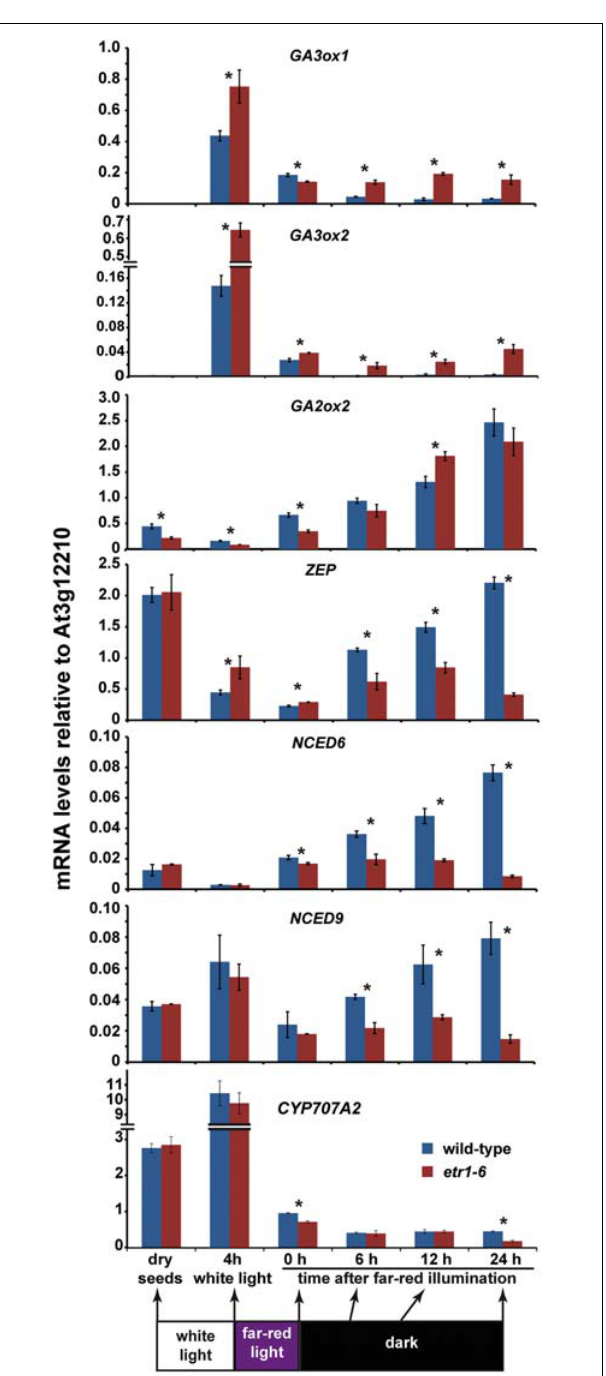
FIGURE 6 |Transcript levels for select GA andABA metabolism genes are affected by loss of ETR1. The levels of transcript for GA3ox1 , GA3ox2 , GA2ox2 , ZEP , NCED6 , NCED9 , and CYP707A2 in wild-type and etr1-6 mutants at various times during germination were measured using qRT-PCR. Data were normalized to the levels of At3g12210 in each seed line at each stage of germination.Transcript levels of dry seeds and imbibed seeds treated with light as indicated were compared. Data were analyzed by t -tests and differences considered statistically significant with P < 0.05. *Denotes that the levels of transcript at that time-point are statistically different between wild-type and etr1-6